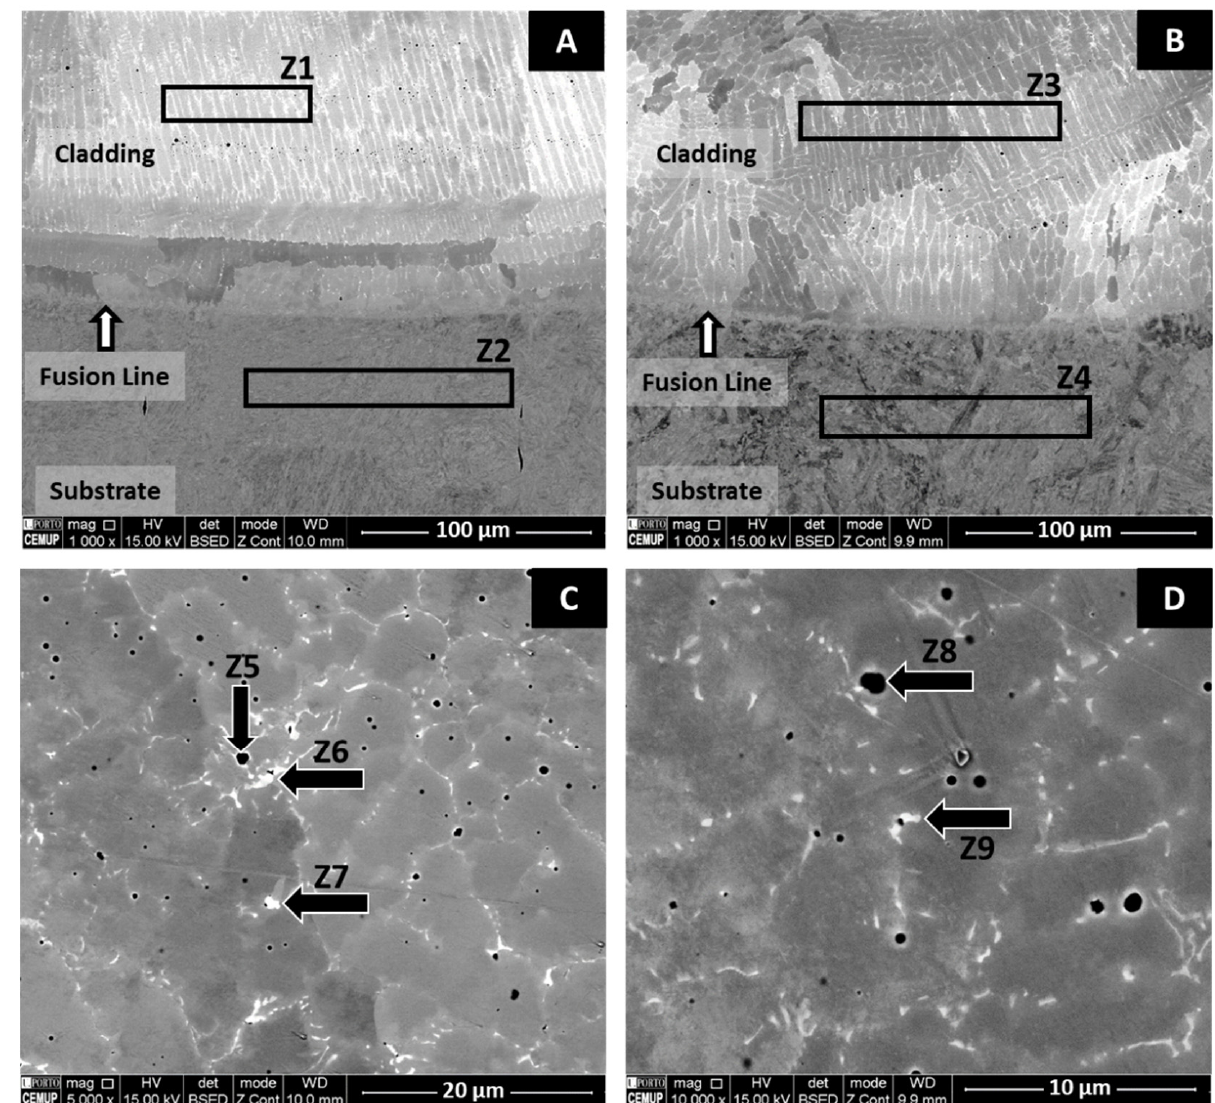
Figure 6. SEM/BSE images showing ( A , B ) the FGM/substrate interface and ( C , D ) higher magnification images for secondary phases analysis from the 50% M625 + 50% M42C layers. ( A , C ) are from FGM produced without PHT, and ( B , D ) with PHT.